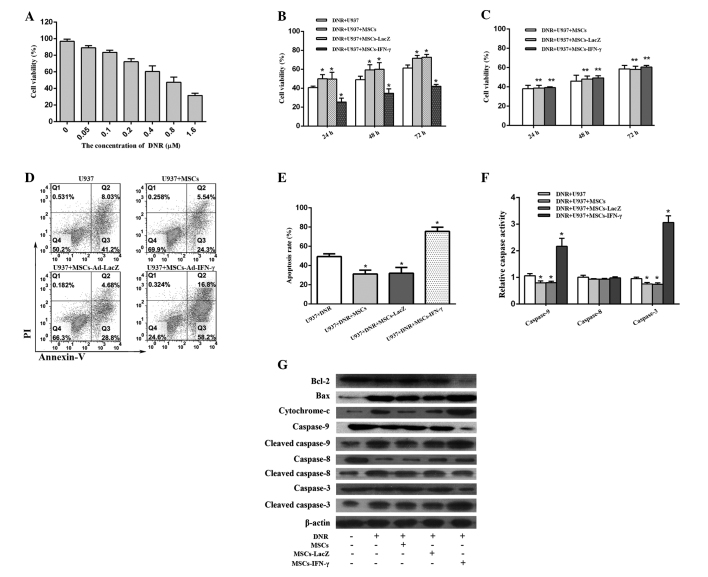
CCK-8 cytotoxicity assay and apoptosis analysis. (A) U937 cells were incubated with different concentrations of DNR alone for 48 h. (B) U937 cells were incubated with DNR alone or with a combination of DNR and MSCs or MSCs transduced with recombinant adenoviruses for 24, 48 and 72 h. (C) Transwell experiments revealed that U937 cell viabilities were not significantly different among the three cocultured groups at different time points. P, no significance. (D) Cytograms show the representative apoptotic results following the 48-h incubation. (E) Graph shows the percentage of apoptotic cells. (F) Caspase activity assay was performed in U937 cells (with different treatments) following a 48-h incubation. (G) U937 cells were incubated in various conditions for 48 h, then the key proteins associated with the apoptosis were analyzed by the immunoblot. Experiments were repeated three times and results are presented as the mean ± SD. *P<0.05, vs. the U937 group incubated with DNR alone; **P>0.05, vs. the U937 group incubated with DNR and MSCs. CCK-8, Cell Counting kit-8; DNR, daunorubicin; MSCs, mesenchymal stem cells.